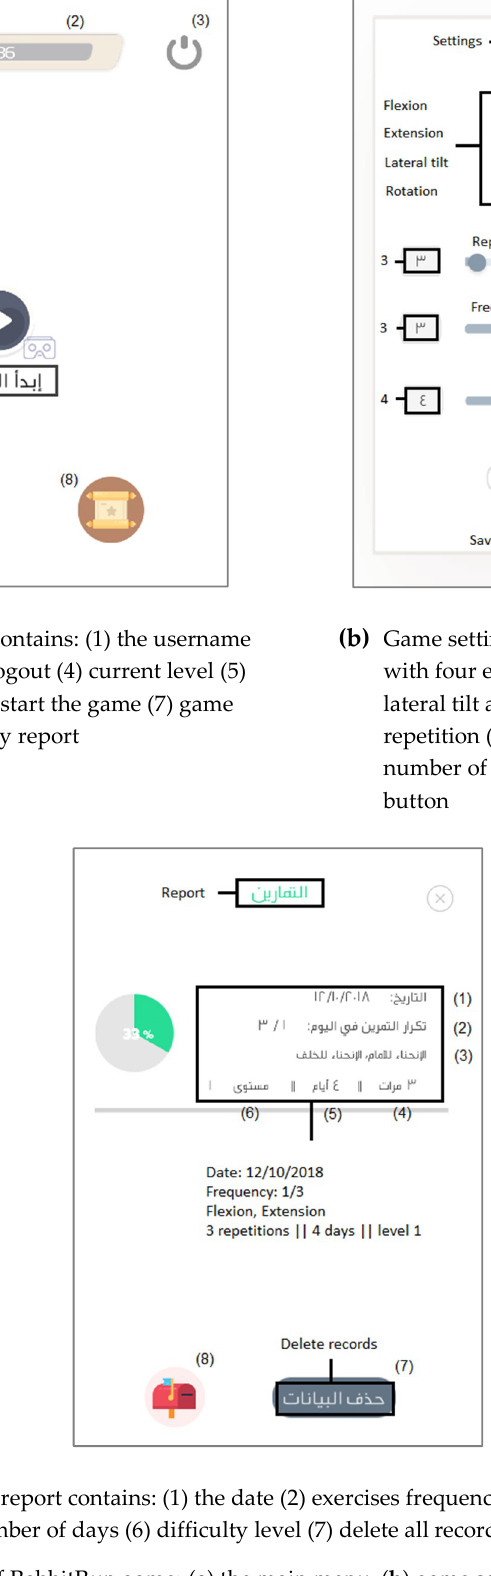
Figure 2. Screenshots of RabbitRun game: ( a ) the main menu, ( b ) game settings, ( c ) exercises history report